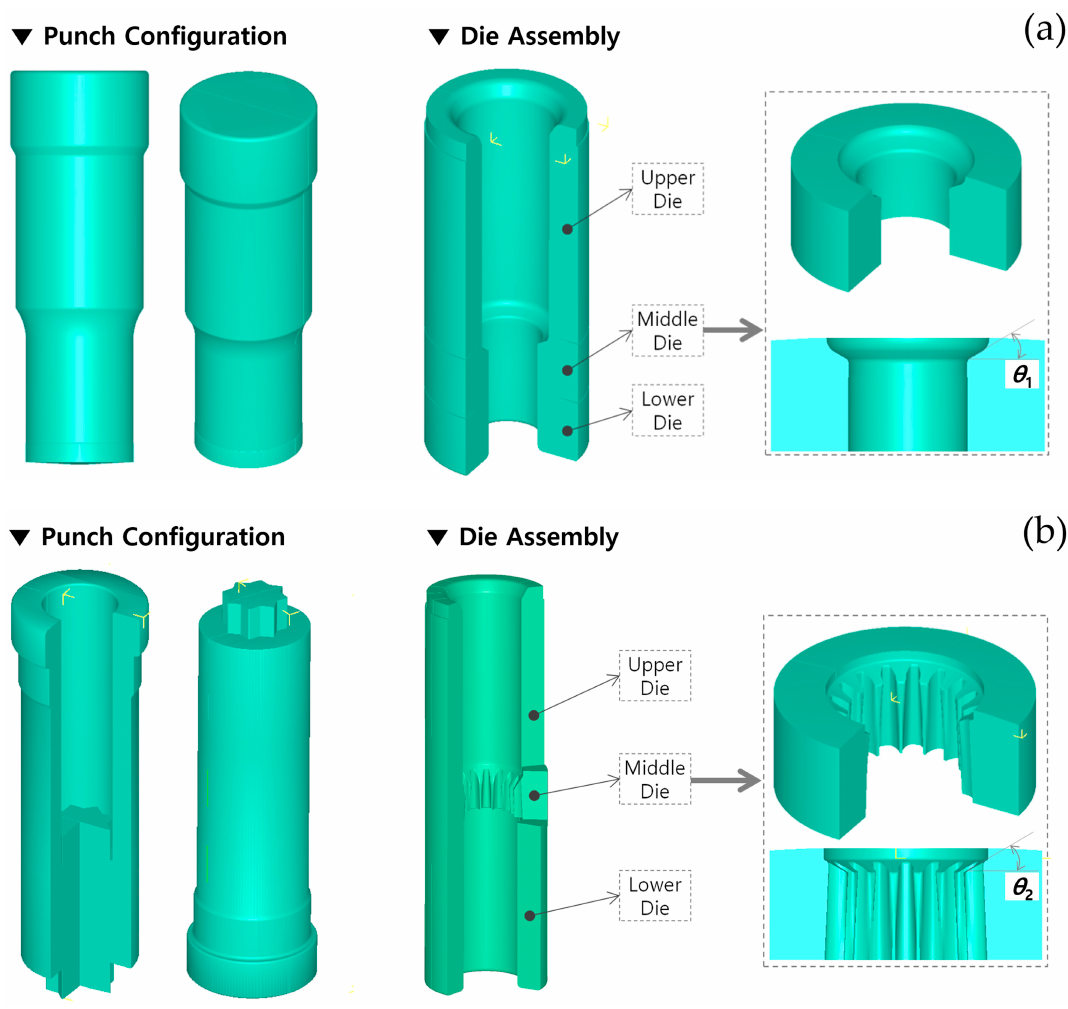
Figure 4. Tool configuration and geometric parameters on each middle die for producing the preform and drive shaft: ( a ) shoulder angle on the middle die for the preform extrusion; ( b ) shoulder angle on the middle die for the combined extrusion.